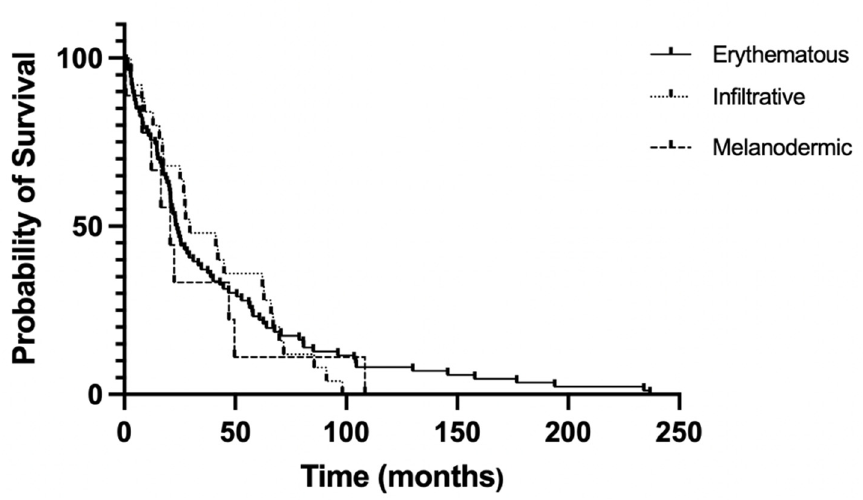
Figure 4. Overall survival in months according to erythrodermic subtype.